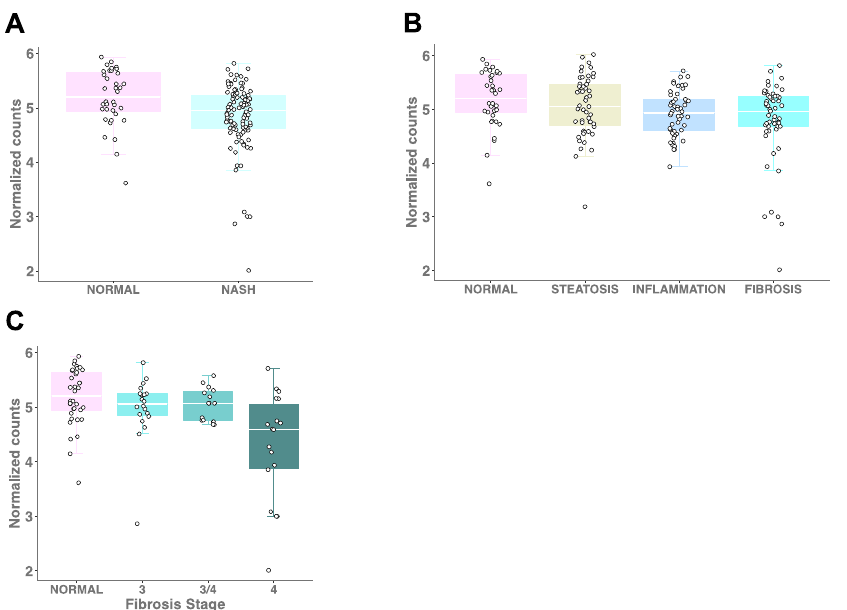
Figure 1. Hepatic PEMT expression decreases with increasing severity of NAFLD. ( A ) PEMT expression in individuals with NASH (inflammation and fibrosis) and those with normal liver histology ( β = − 1.497; p = 0.005). ( B ) PEMT expression levels in participants spanning the histological spectrum of NAFLD ( β = − 909; p = 2.2 × 10 − 4 ). The expression levels were significantly different when comparing inflammation and fibrosis groups with controls ( β = − 1.476; p = 0.015) and ( β = − 1.504; p = 0.013, respectively), but not when comparing steatosis with controls ( β = − 0.550; p = 0.222). ( C ) PEMT expression in different fibrosis stages and controls ( β = − 0.152; p = 0.001).